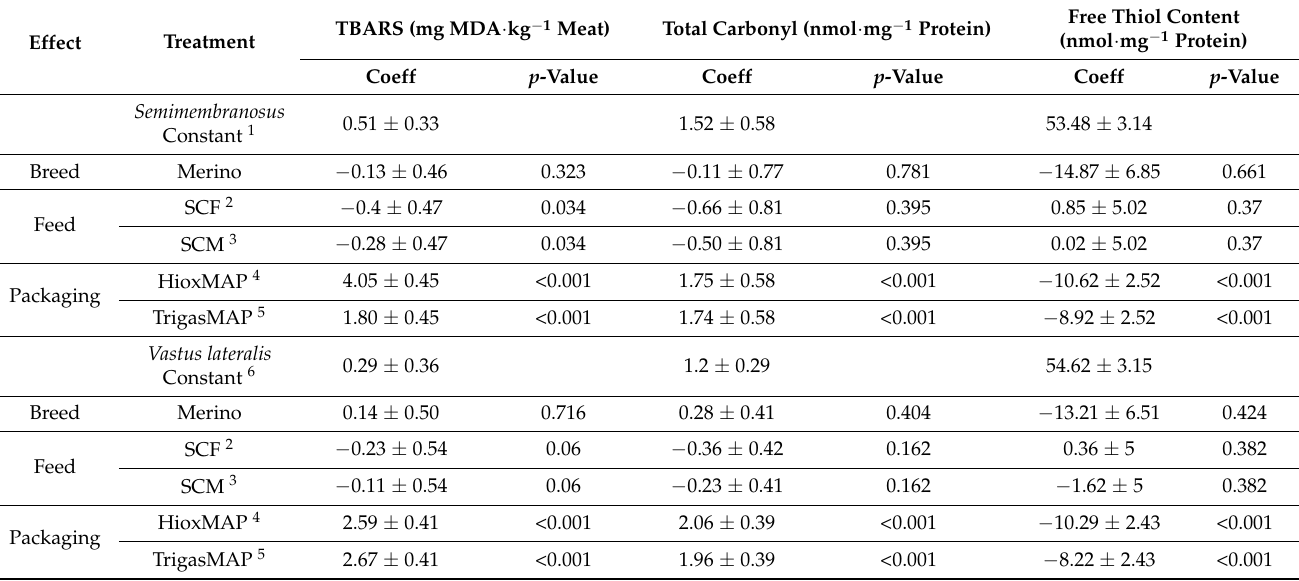
Table 3. Effect of breed, feed and packaging method on lipid and protein oxidation measurements of sheep Semimembranosus (topside) and Vastus lateralis (knuckle).